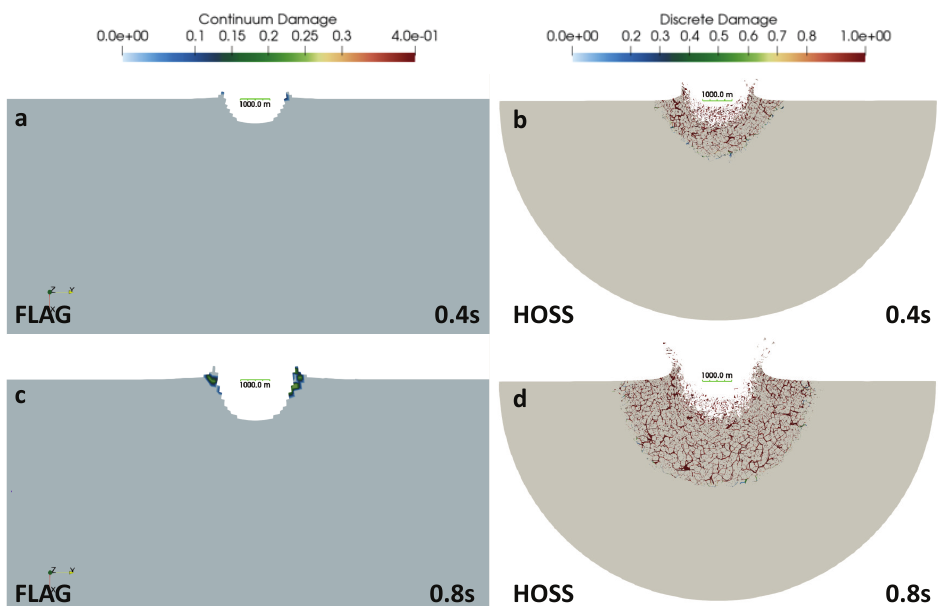
Figure 14. Continuum and discrete damage measures from a 5 × 10 3 m/s normal impact in which strength and damage are considered in the material models. Snapshots are shown at 0.4 s ( a , b ) and 0.8 s ( c , d ) and are calculated from 3D simulations from FLAG and HOSS. ( a , c ) show continuum damage from 3D FLAG simulations, and ( b , d ) show discrete damage from 3D HOSS simulations. The length of the horizontal green bar shown inside the crater represents a distance of 1000